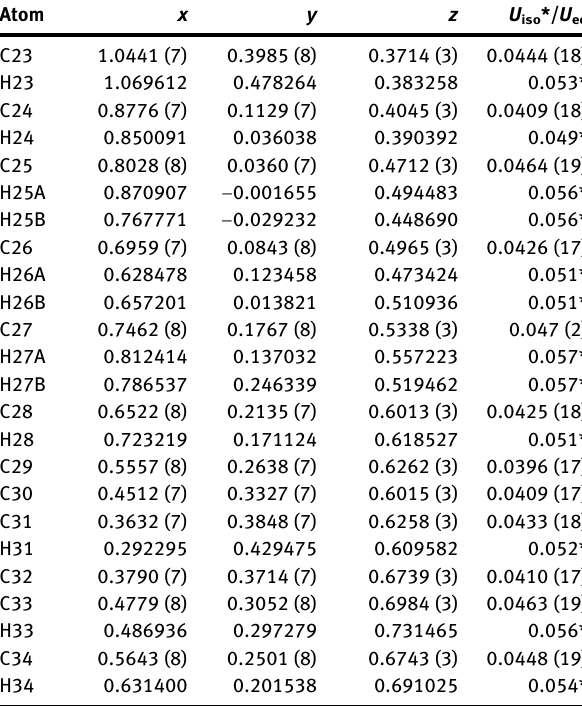
Table  : Fractional atomic coordinates and isotropic or equivalent isotropic displacement parameters (Å 